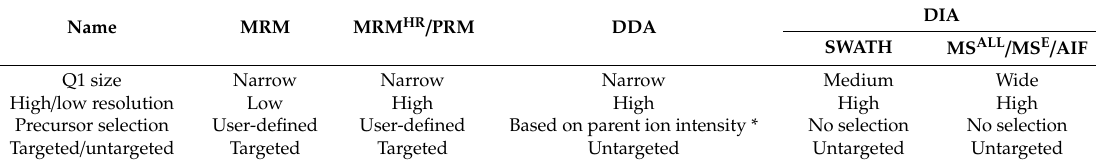
Table 1. Overview of the most commonly used tandem mass spectrometry modes. MRM: multiple reaction monitoring, MRM HR : high-resolution multiple reaction monitoring, PRM: parallel reaction monitoring, DDA: data-dependent acquisition, DIA: data-independent acquisition, SWATH: sequential window acquisition of all theoretical mass spectra and AIF: all-ion fragmentation. Q1 (first quadrupole) size, resolution, precursor selection and targeted / untargeted profile are